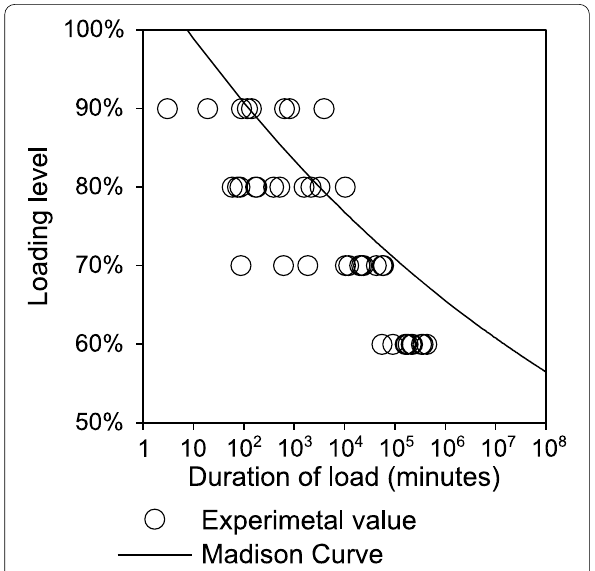
Fig. 7 Duration of load of the specimens. Three specimens loaded with 90% loading level showed failure within 1 min after loading and were not shown. Madison curve represents empirical hyperbolic curve (Eq.